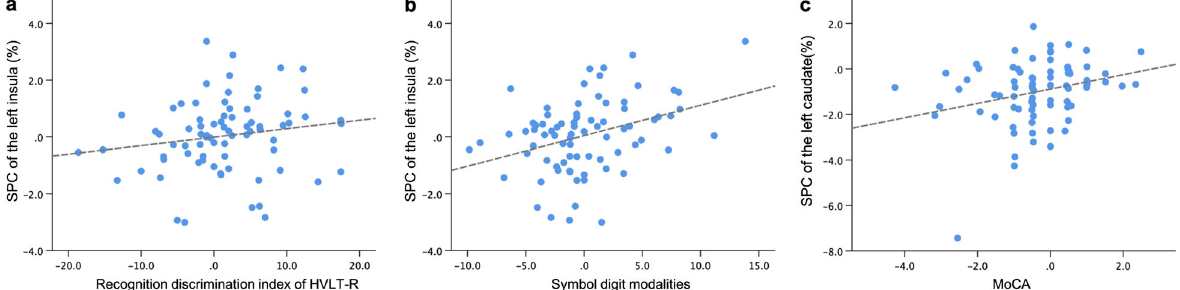
Fig. 3 Correlations between SPC and changes in clinical parameters. The mean symmetrized percent changes (SPC) of the left insula positively correlated with ( a ) changes in recognition discrimination index of HVLT-R and ( b ) those in symbol digit modalities. c The mean SPC of the left caudate revealed positive correlation with changes in MoCA. The x-axis represents changes in each clinical parameter calculated as: (score at time 2 – score at time 1)/(time 2 – time 1). MoCA, Montreal cognitive assessment; HVLT-R, Hopkins verbal learning